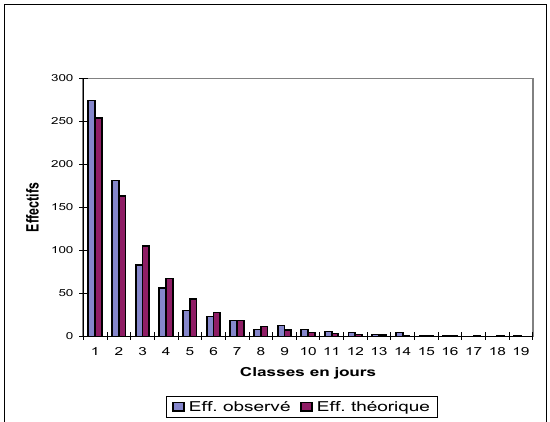
Fig. 1 Distribution de l’événement sec à la station de